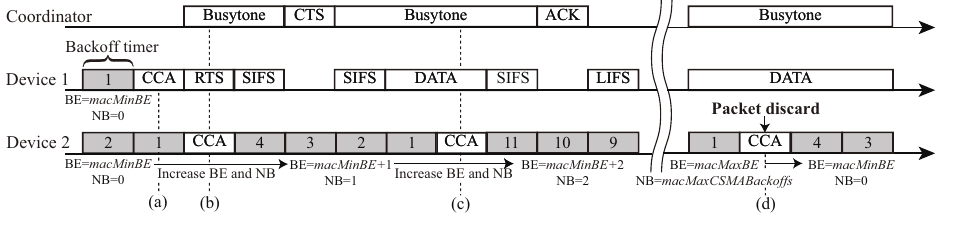
Figure 4. Channel access example of the FD-RTS/CTS